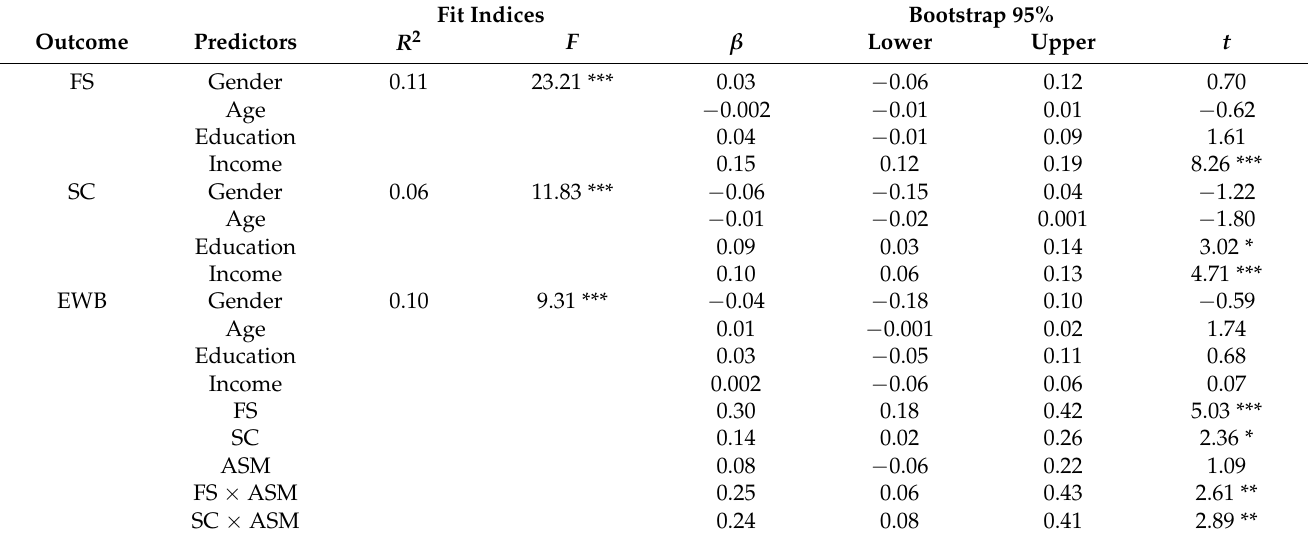
Table 8. Testing the moderated mediation effects for EWB in study 2.